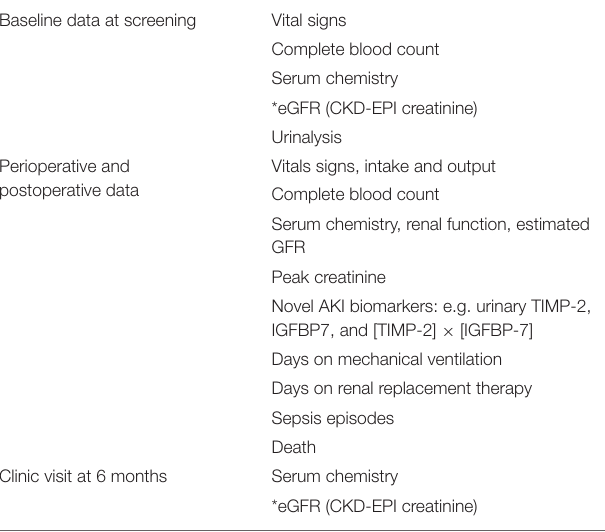
TABLE 1 | Clinical and laboratory data to be collected at various time points. Baseline data at